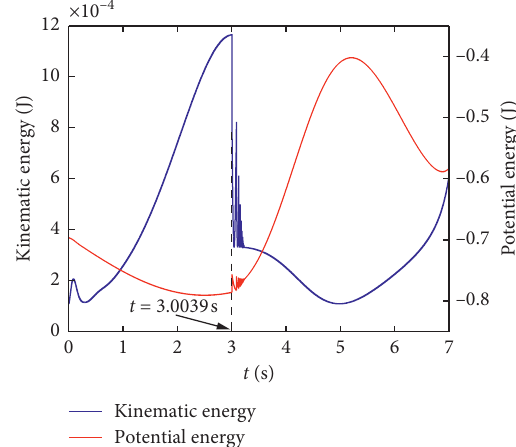
Figure 15: Driven moment